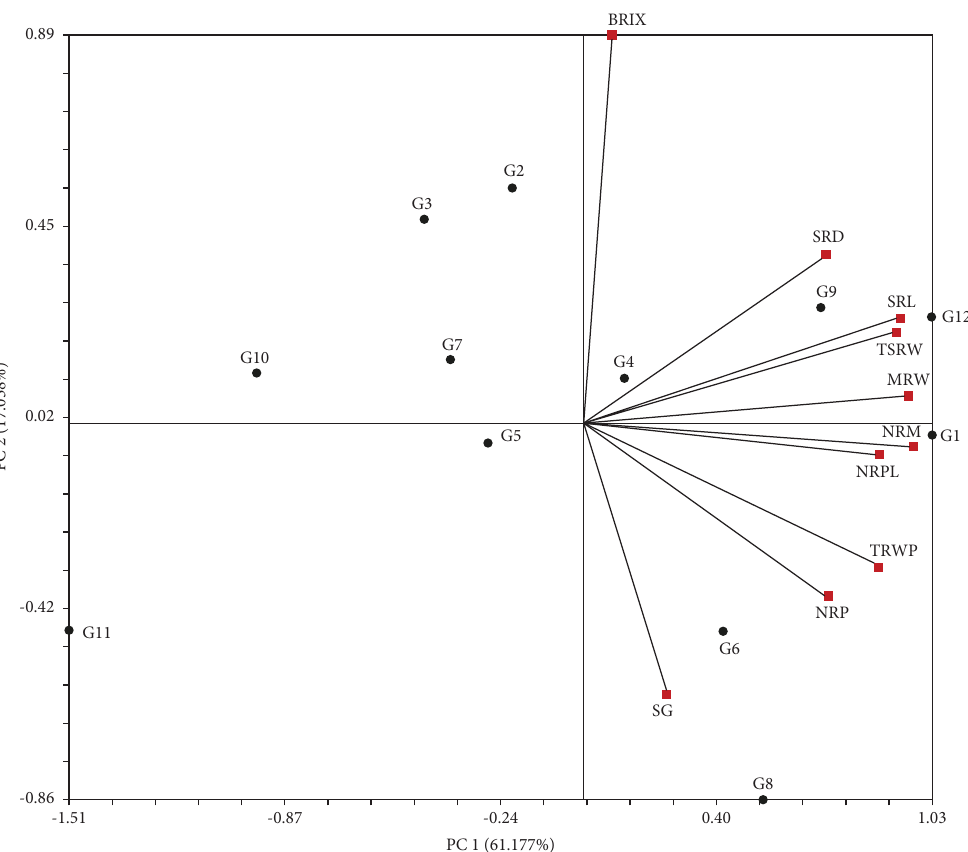
Figure 2: Distribution pattern of nine genotypes PFSP and three commercial varieties as checks based on ten agronomic traits in Jatinangor